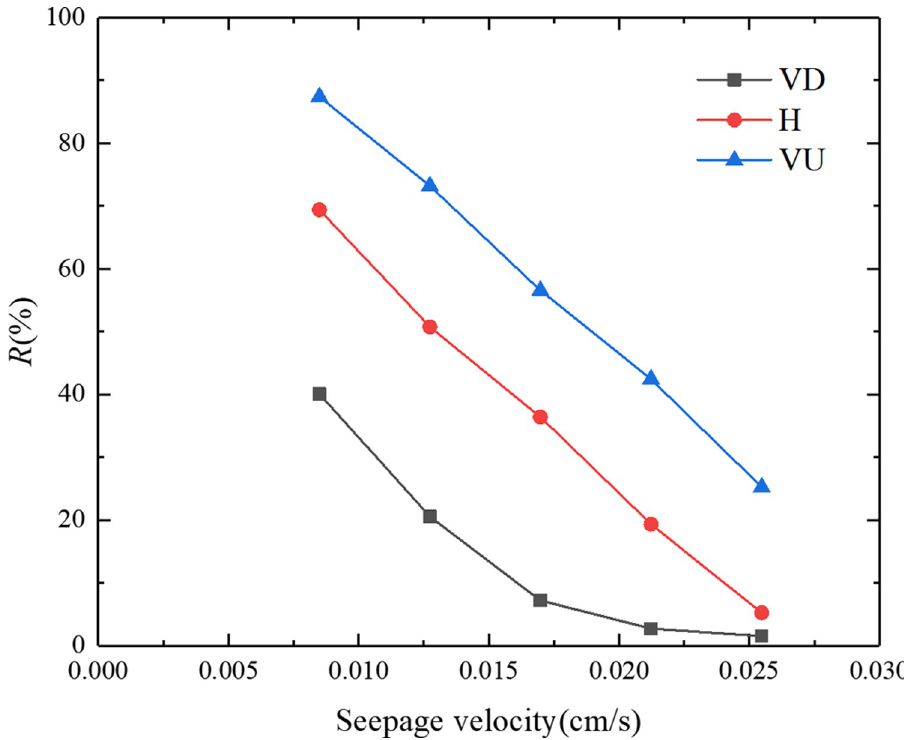
Fig 10. Relationship between the particle adsorption coefficient and the seepage velocity under the three different seepage directions.